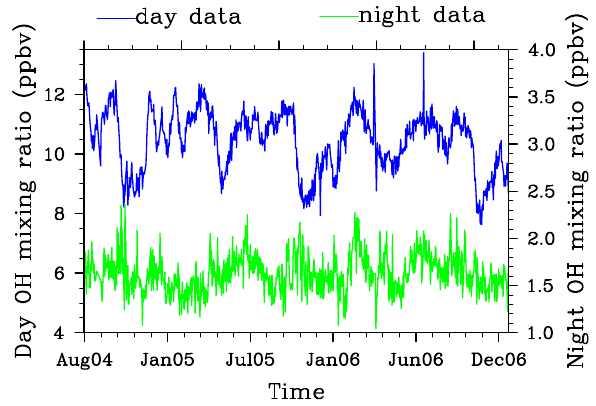
Fig. 1. Tropical mean OH mixing ratios (27 ◦ S–27 ◦ N) at ∼ 78km altitude for the period from August 2004 to December 2006 ob- tained from AURA MLS. Green curve: nighttime averages. Blue curve: day-time only.